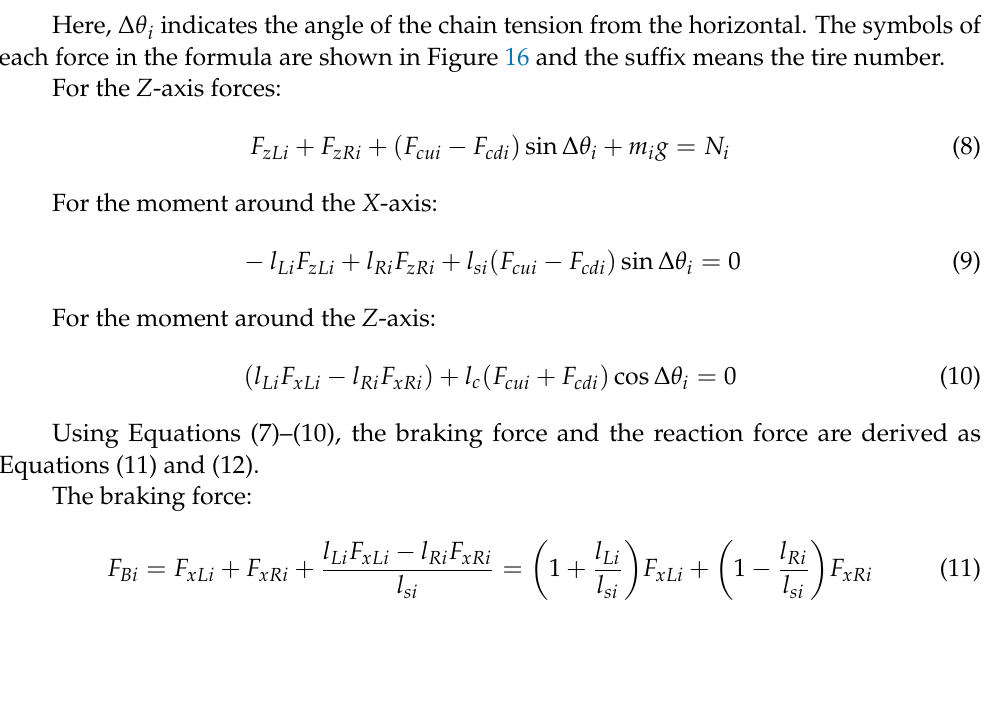
Here, Δ θ i indicates the angle of the chain tension from the horizontal. The symbols of each force in the formula are shown in Figure 16 and the suffix means the tire number. For the Z -axis forces: